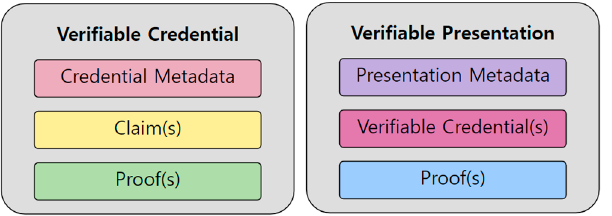
Figure 1. Basic components of a Veri fi able Credential and a Veri fi able Presentation [6].